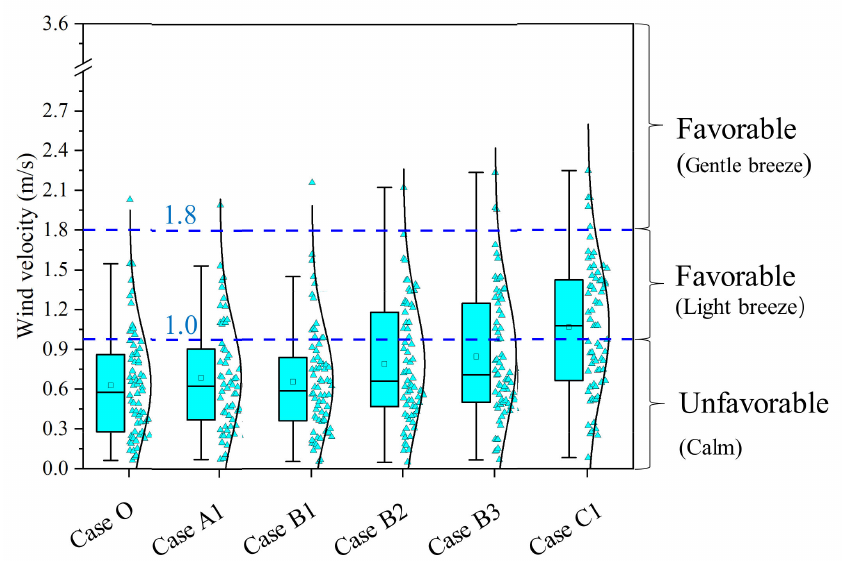
Figure 13. Wind velocity box plots for the six cases.